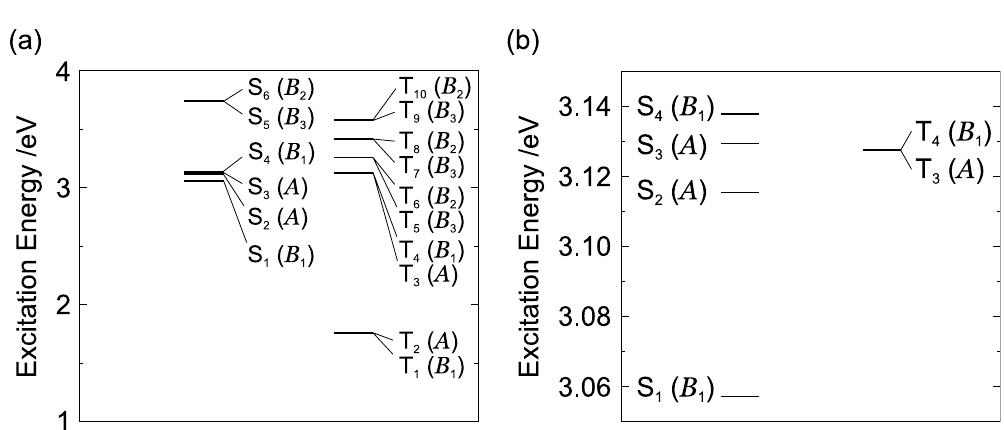
Figure 3. ( a ) Energy levels of the excited states in BD1 at the optimized structure for S 0 , and ( b ) an enlarged view of the relevant